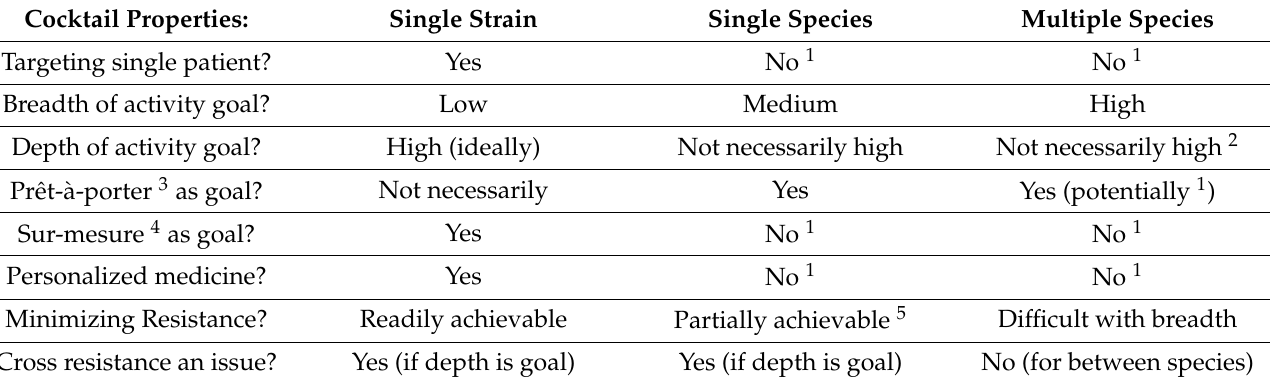
Table 1. Contrasting cocktails based on spectrum of activity breadth and